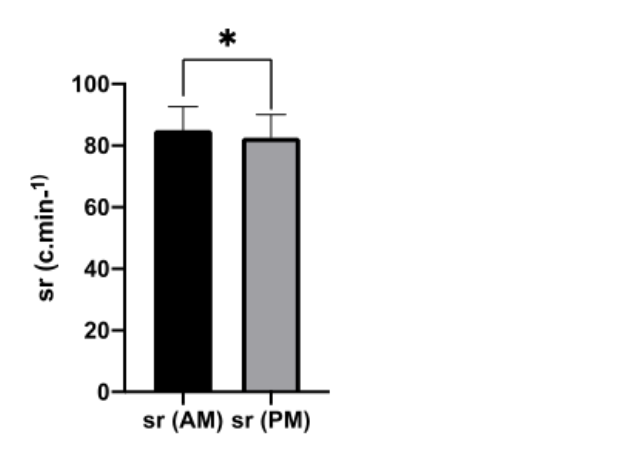
Figure 1. Stroke rate values in the morning (SR_AM) and afternoon (SR_PM) time trials (mean ± SD); * p < 0.05.